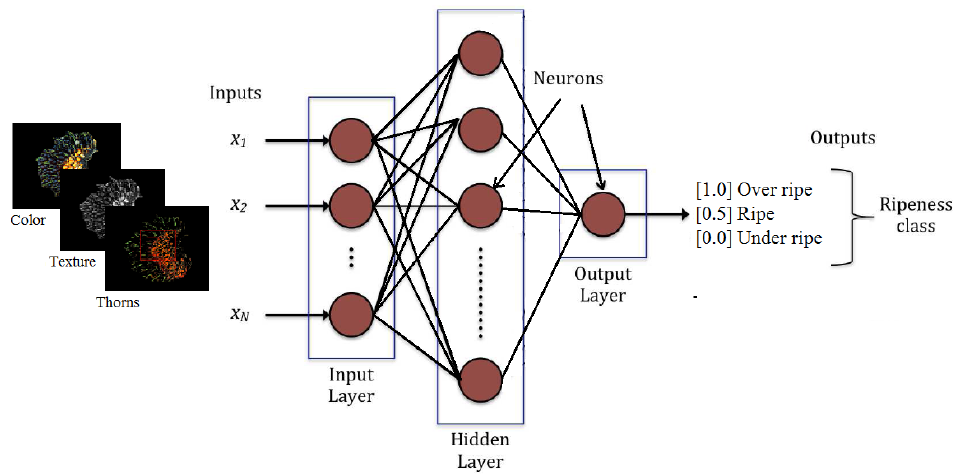
Figure 7. ANN multi-layer structure directly operating with a single port of the FFB oil palm grading system.